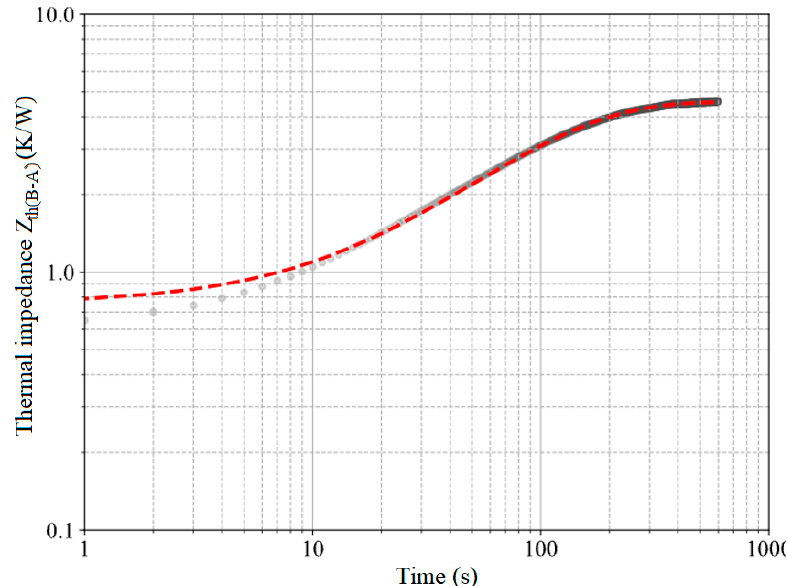
Figure 8. Experimental results of the thermal impedance Z thB-A at the SP1 test point for P out = 700 W. The measured data (marked on grey) were approximated with first order polynomial (marked od dashed-red line).